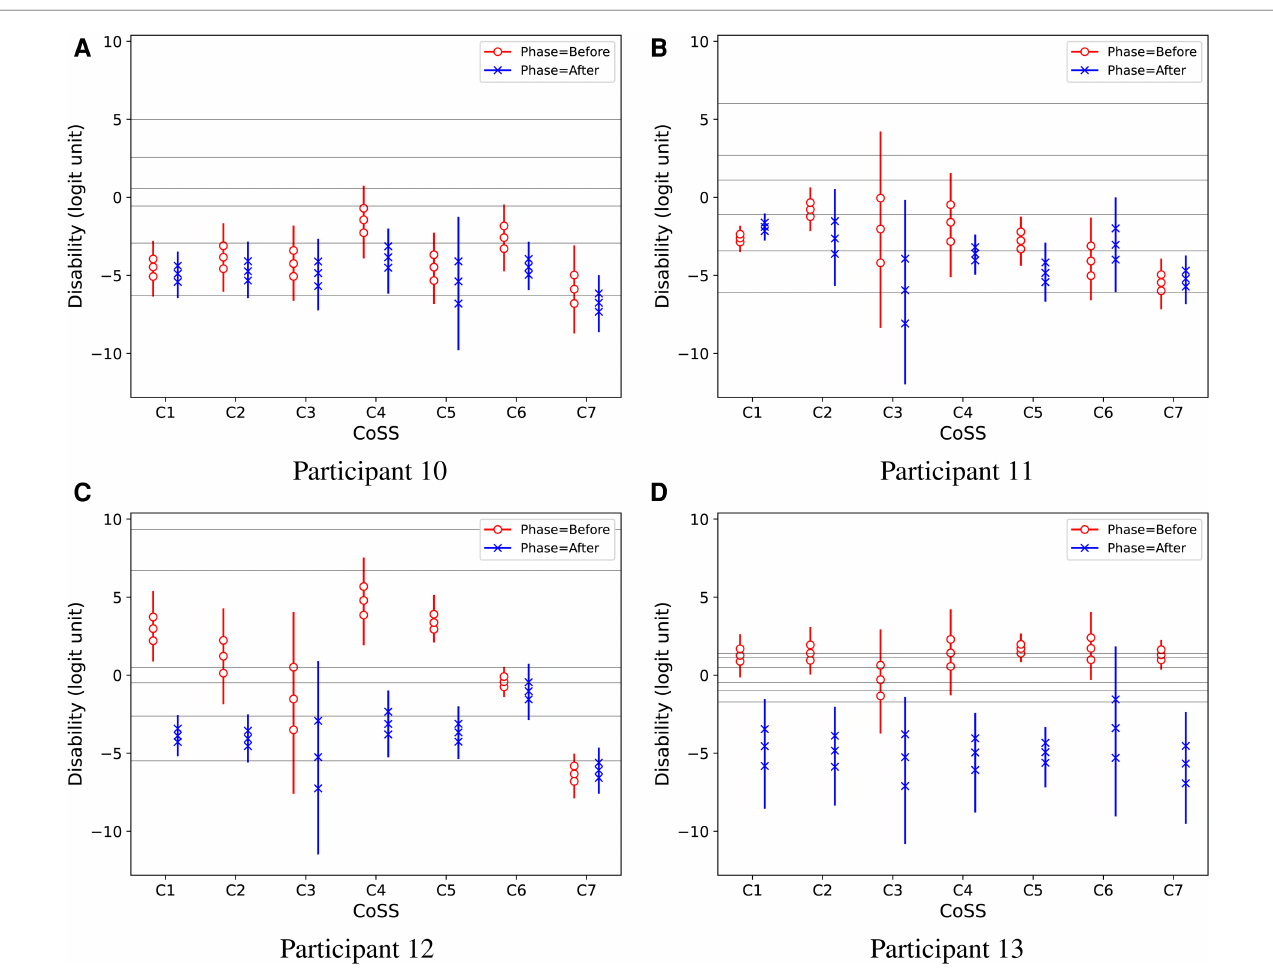
FIGURE 7 Predictive Disability results of four study participants, denoted by numbers as in the original IHAB-RL study (6, Figures 6 , 7 ). Vertical lines show 95% credible intervals for the marginal distributions of Disability values. Marker symbols show 25-, 50-, and 75-percentiles. Thin horizontal lines across the plots show median estimated response thresholds for the ordinal rating categories. ( A ) Participant 10, ( B ) Participant 11, ( C ) Participant 12 and ( D ) Participant